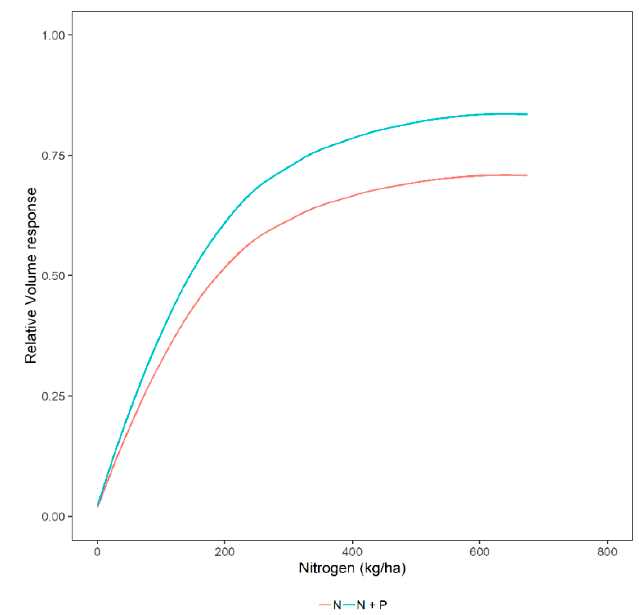
Figure 5. Hypothetical relative volume response for different levels of nitrogen (kg ha − 1 ) and the interaction with phosphorus, assuming P -limitation exists.